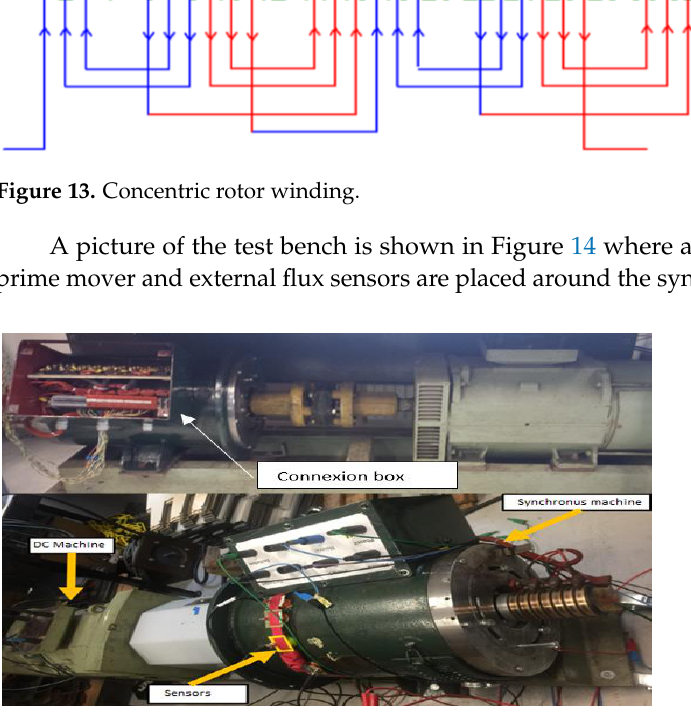
Figure 14. Experimental test bench with special synchronous generator modified to enable inter-turn short circuits.